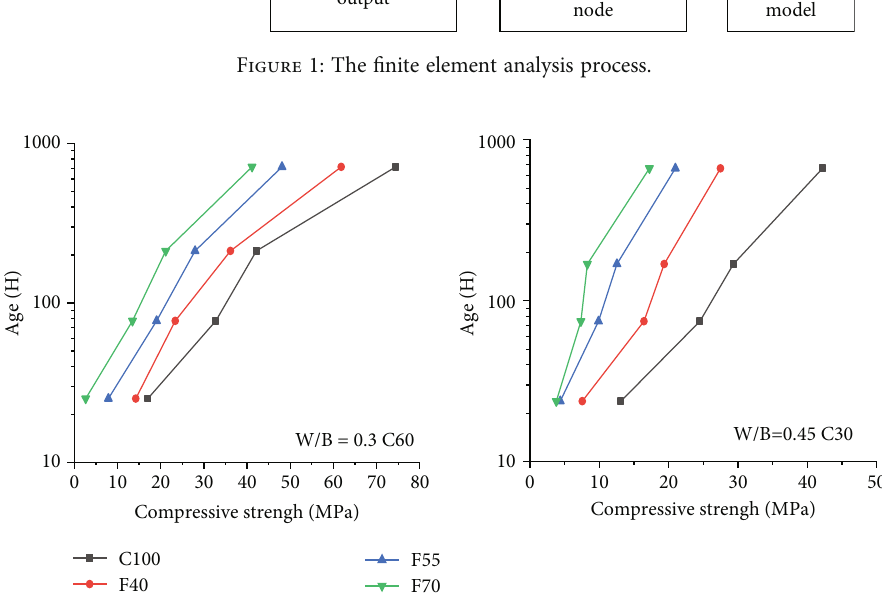
Figure 2: Early compressive strength of concrete with di ff erent fl y ash contents. Table 4: The internal stress values of the concrete specimens with di ff erent amounts of fl y ash (MPa). 3 Concrete